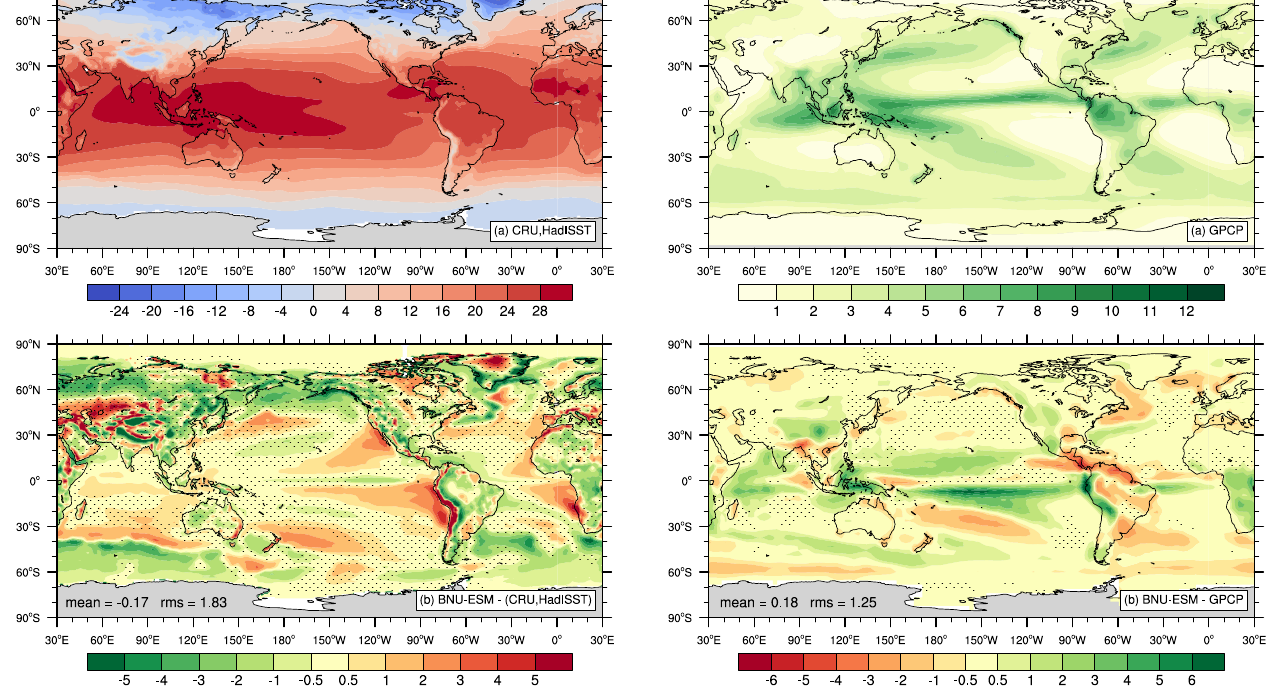
Figure 8. Climatological mean surface temperature from the 0.5 ◦ × 0.5 ◦ CRU TS 3.1 (Harris et al., 2014) and 1 ◦ × 1 ◦ HadISST (Rayner et al., 2003) observations for the period 1976–2005 (a) . Annual mean surface temperature bias ( ◦ C) of BNU-ESM relative to the CRU TS 3.1 and HadISST data sets for the period 1976– 2005 (b) . All data sets are regridded to 1 ◦ × 1 ◦ resolution. Dotted area indicates non-significant regions at the 95% confidence level.